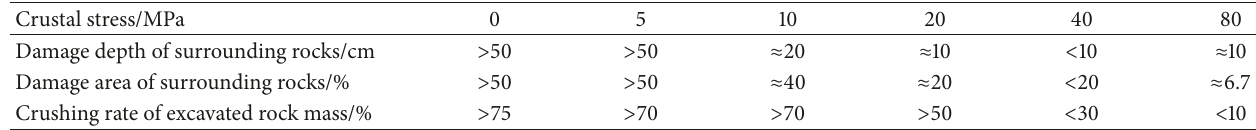
Table 6: The damage depth, area of surrounding rocks, and the crushing rate of excavated rock mass. Crustal stress/MPa 0 Damage depth of surrounding rocks/cm Damage area of surrounding